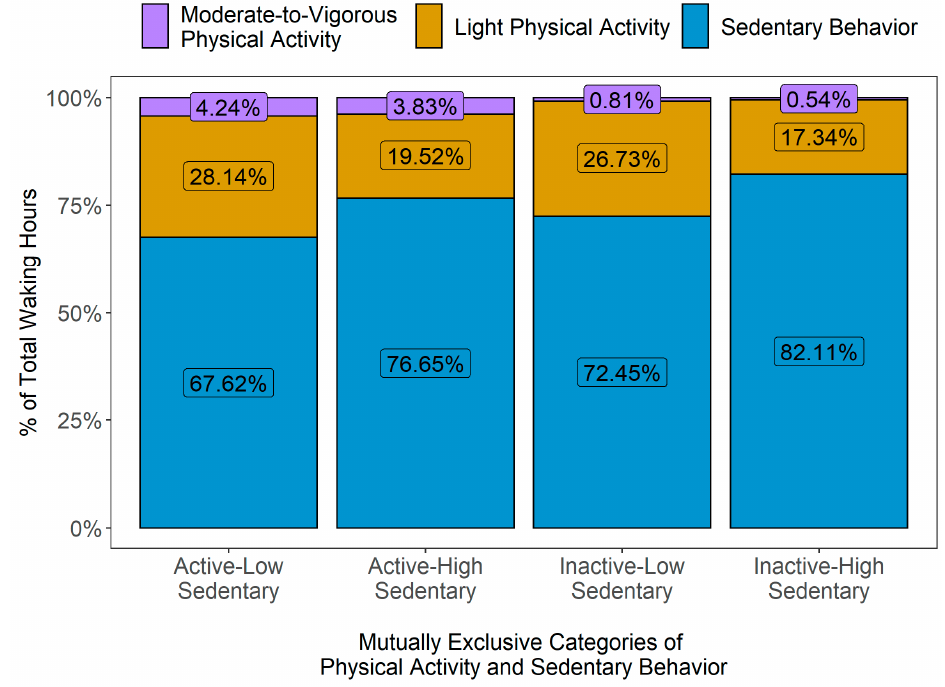
Figure 3. Distribution of average physical activity levels by mutually exclusive behavioral categories of physical activity (PA) and sedentary behavior (SB).